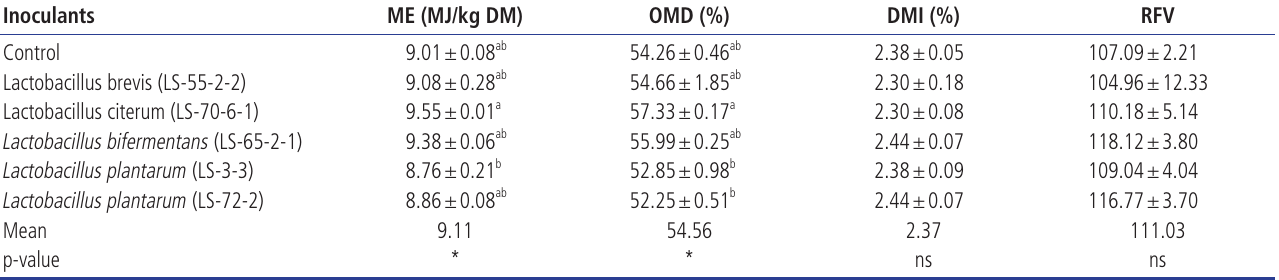
Table 7. Effects of different bacterial inoculants on means of nutritive values of ensiled silages opened at the time T